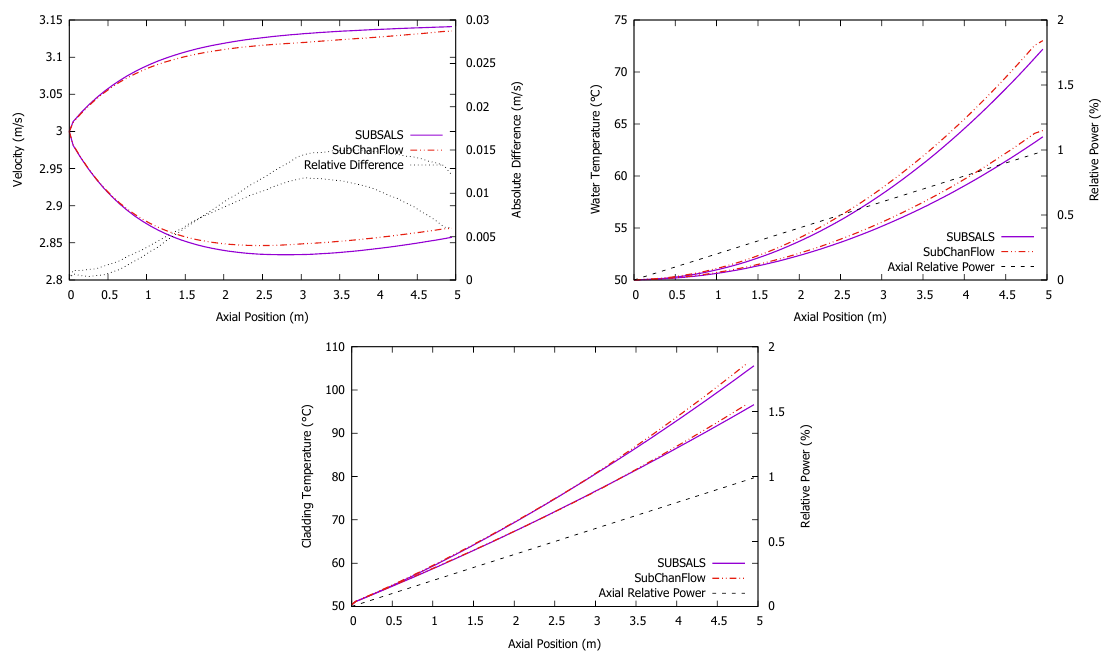
Figure 7. Comparison of axial velocity (top left), water temperature (top right) and cladding temperature (bottom) distribution calculations with linearly increasing axial power